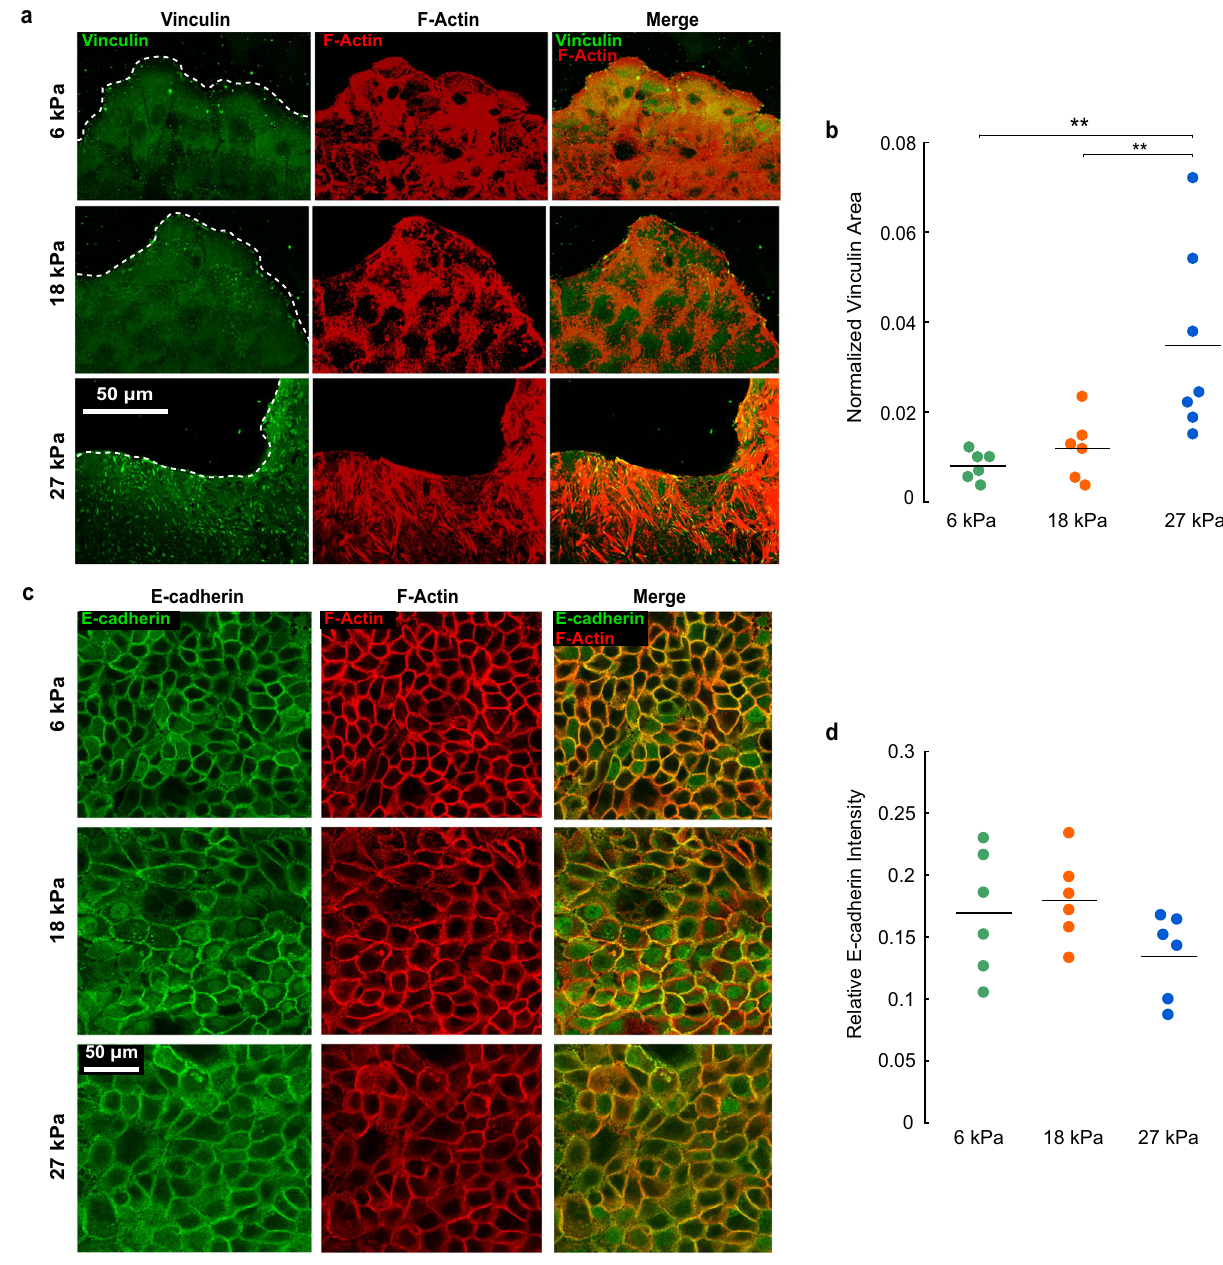
Figure 1. Effect of substrate stiffness on cell–substrate and cell–cell adhesions. ( a ) Confocal images of HaCaTs stained for vinculin (green) and actin (red) on substrates having moduli of 6, 18, and 27 kPa. ( b ) Effect of substrate stiffness on normalized vinculin area. ( c ) Confocal images of HaCaTs stained for E-cadherin (green) and actin (red) for varied substrate stiffness. ( d ) Relative E-cadherin intensity (difference between junctional and cytoplasmic intensities divided by the sum) for varied substrate stiffness. No statistical effect of substrate stiffness on relative intensity was present. For panels ( b , d ), each data point represents an average over a statistically independent field of view. Horizontal lines indicate